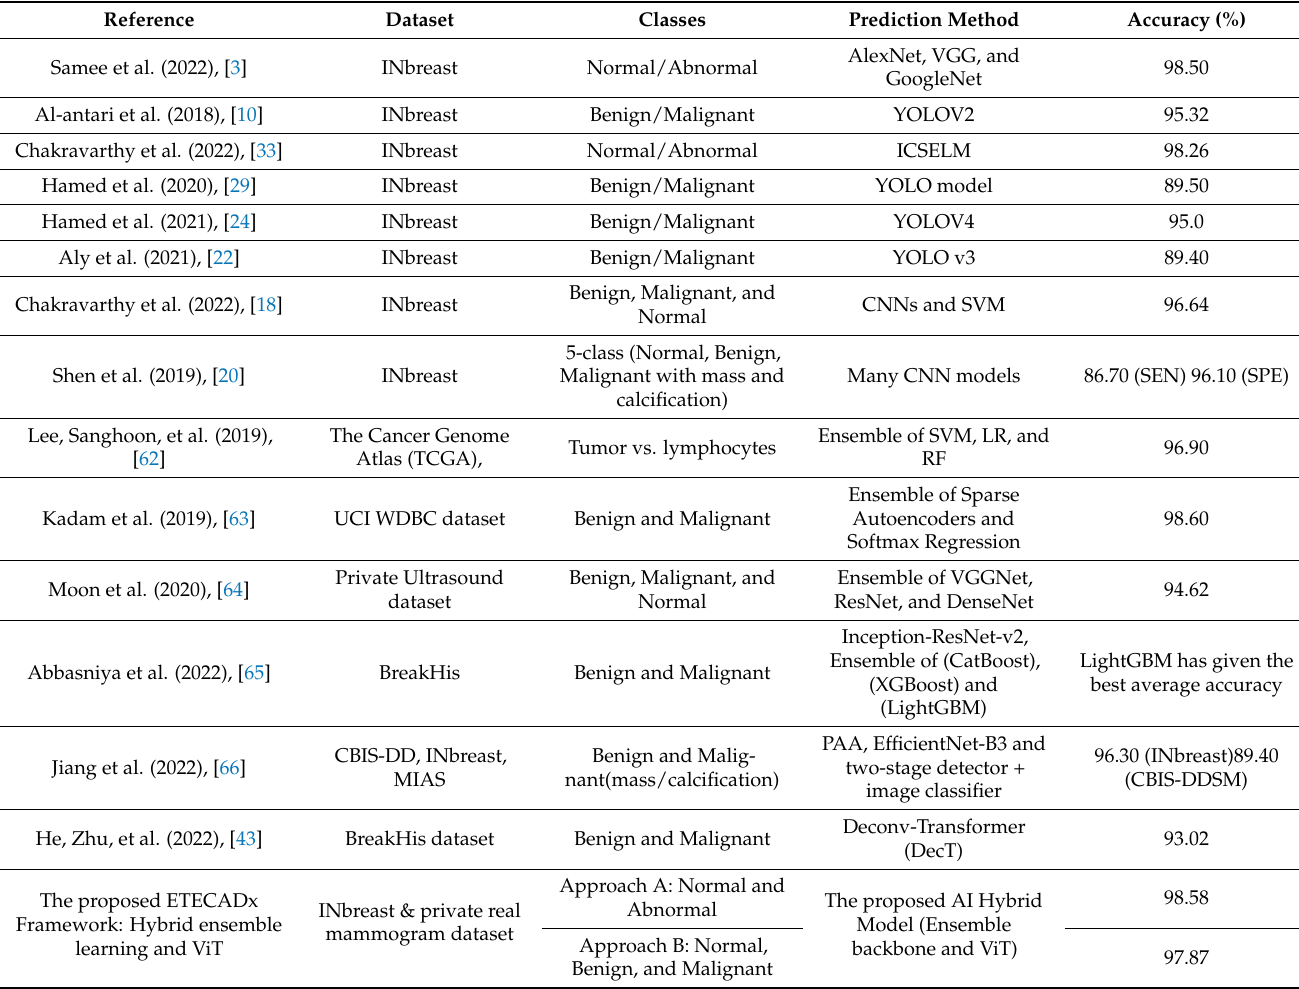
Table 12. Comparison evaluation results against the latest AI research works for breast